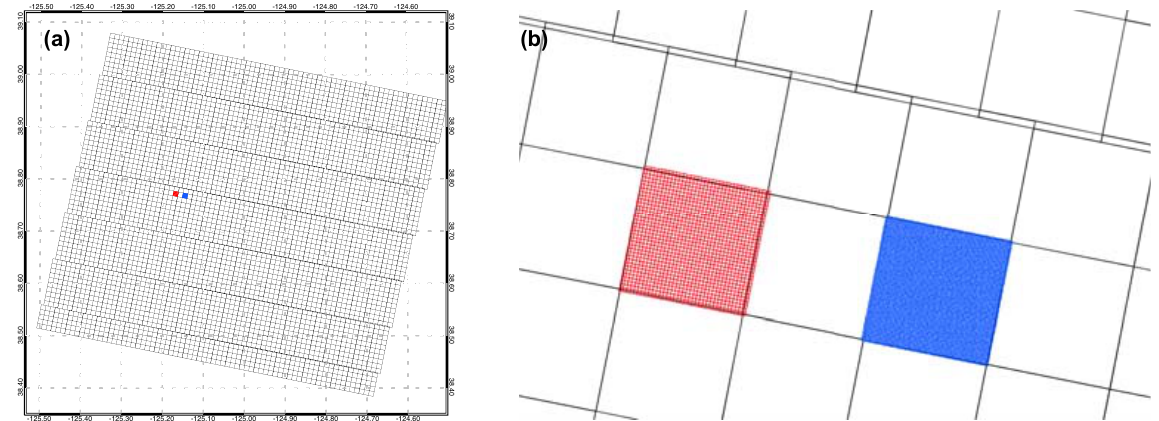
Figure 9. (a) Derived MODIS pixels (gray lines) for the MBL scene observed on 10 June 2005 (C19). For two individual MODIS pixels all co-located ASTER pixels in the VNIR (blue lines) and SWIR (red lines) are shown, which are characterized by a horizontal resolution of 15 and 30m, respectively. (b) Closeup of the two MODIS